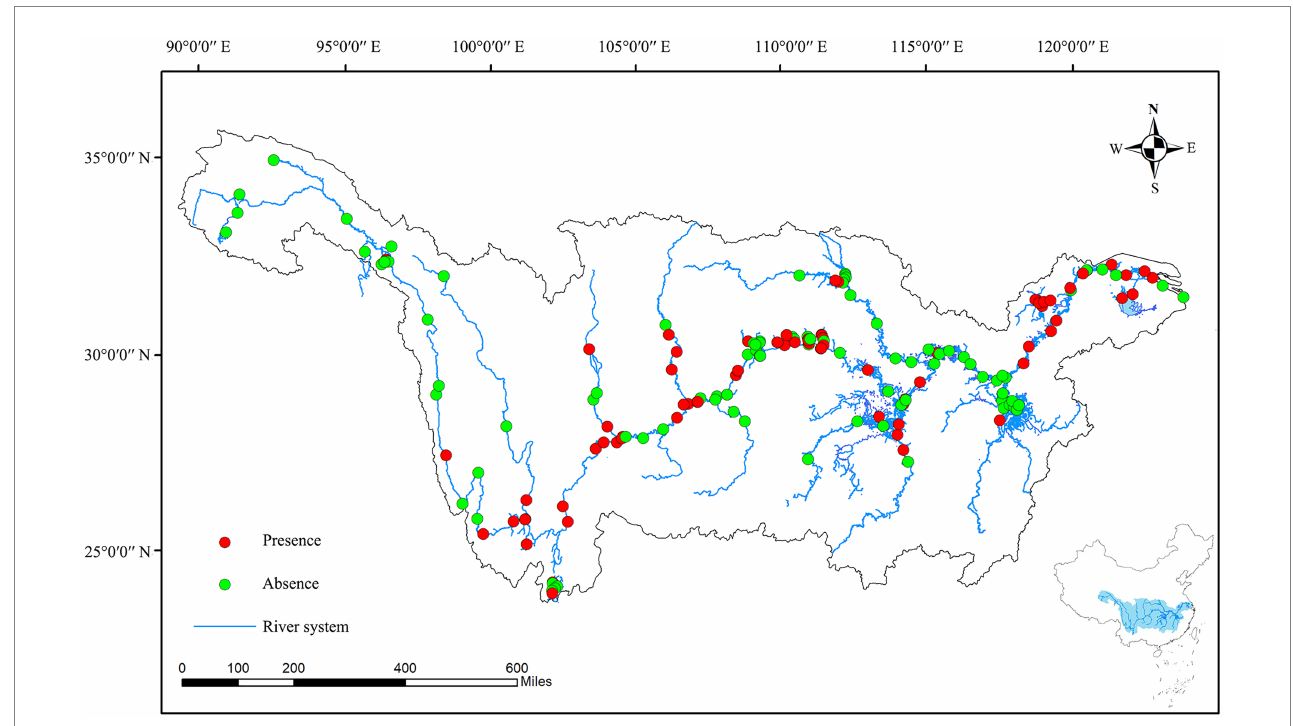
FIGURE 1 Presence and absence of colonial volvocine algae in each sampling